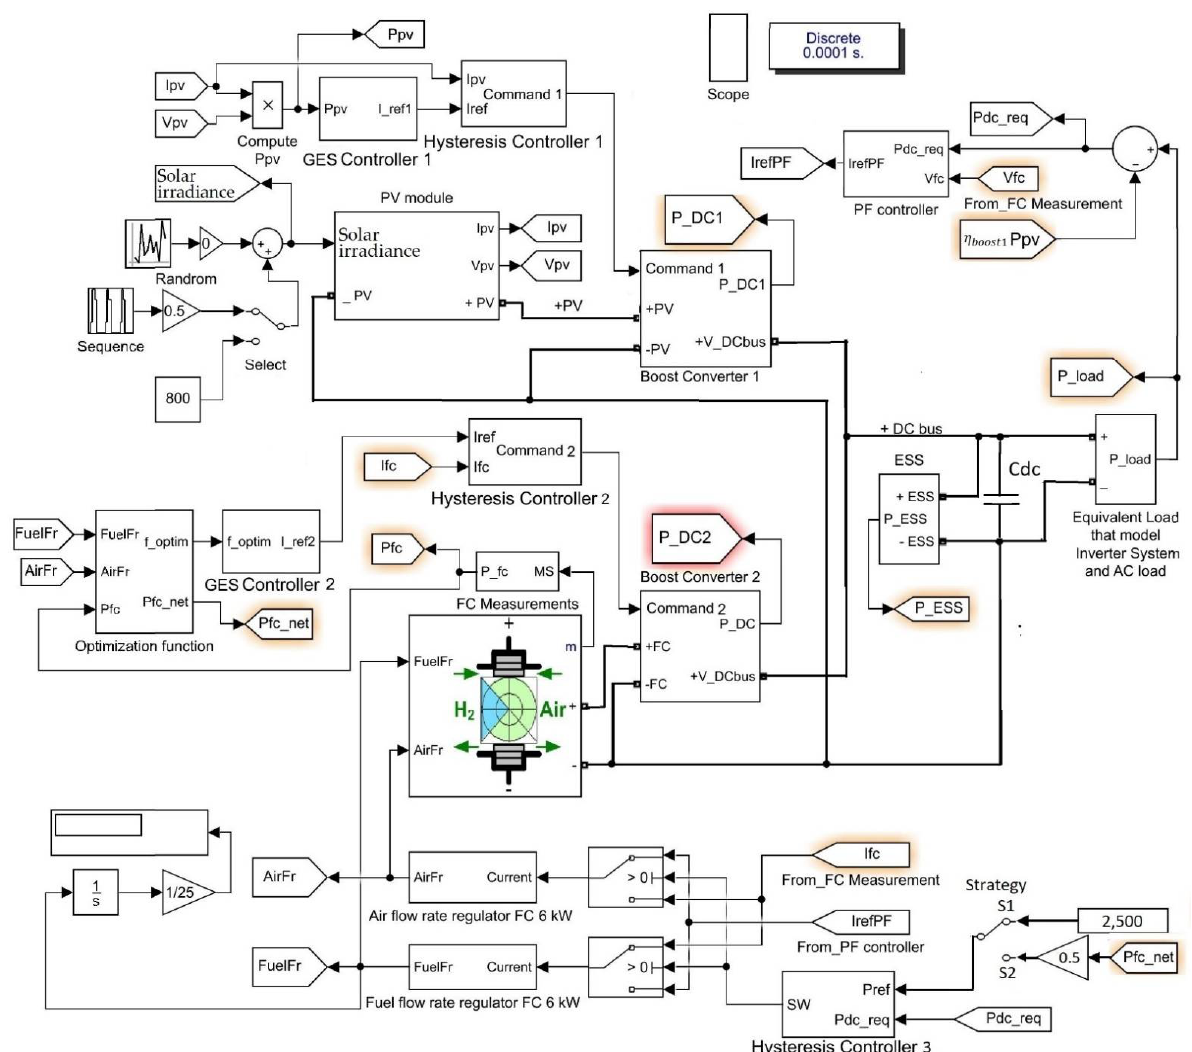
Figure 2. PV/FC/ESS hybrid power system diagram using strategies S1 and S2.